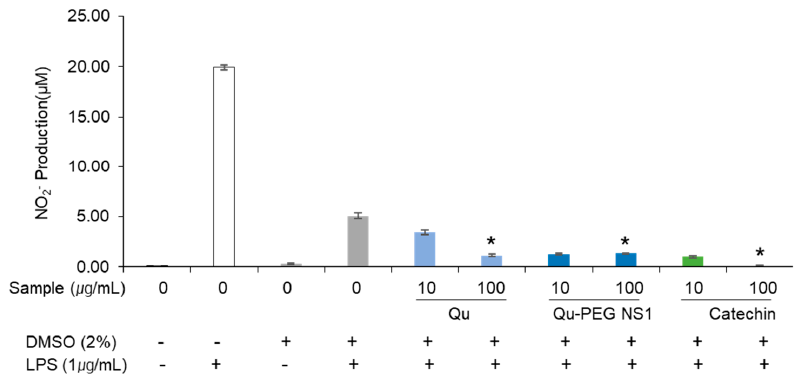
Figure 8. Effects of Qu and Qu-PEG NS on NO production by RAW 264.7 cells in the presence of LPS. Results are the mean ± SD of test samples, * p < 0.05 indicates a significant difference from the control at a concentration of 100 μ g/mL.